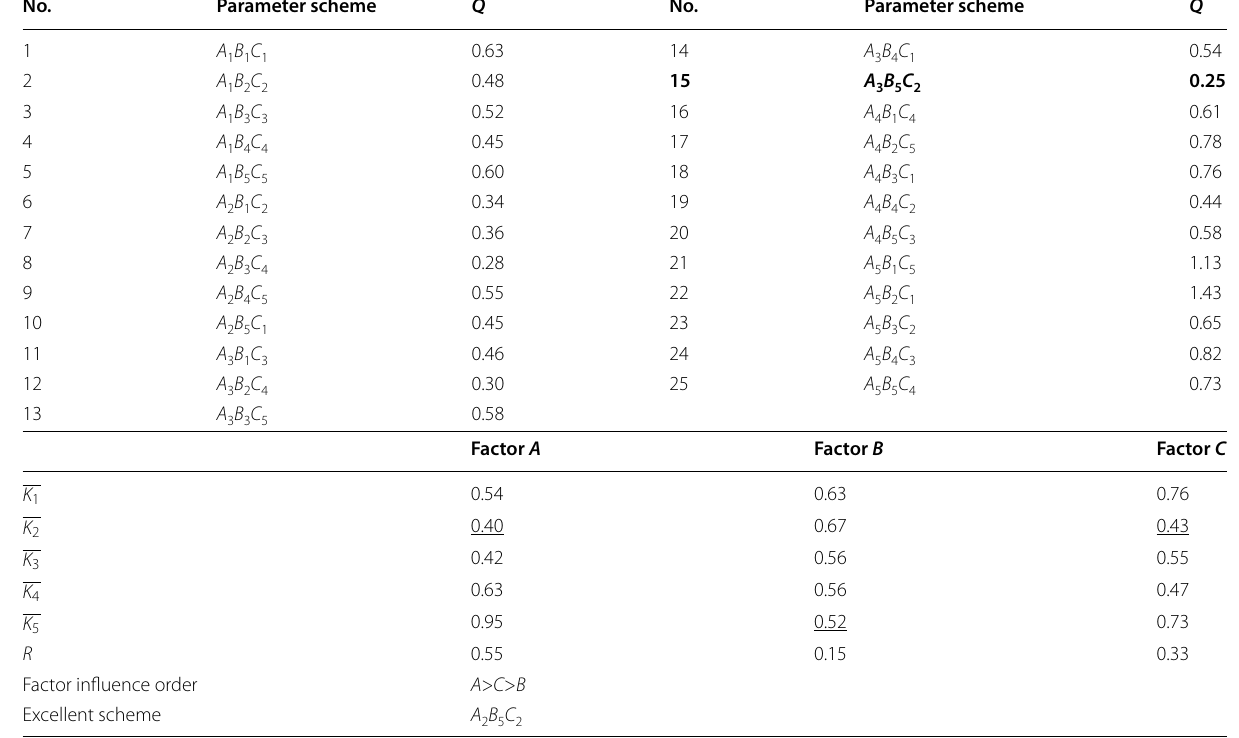
Table 3 Experiments result and range analysis